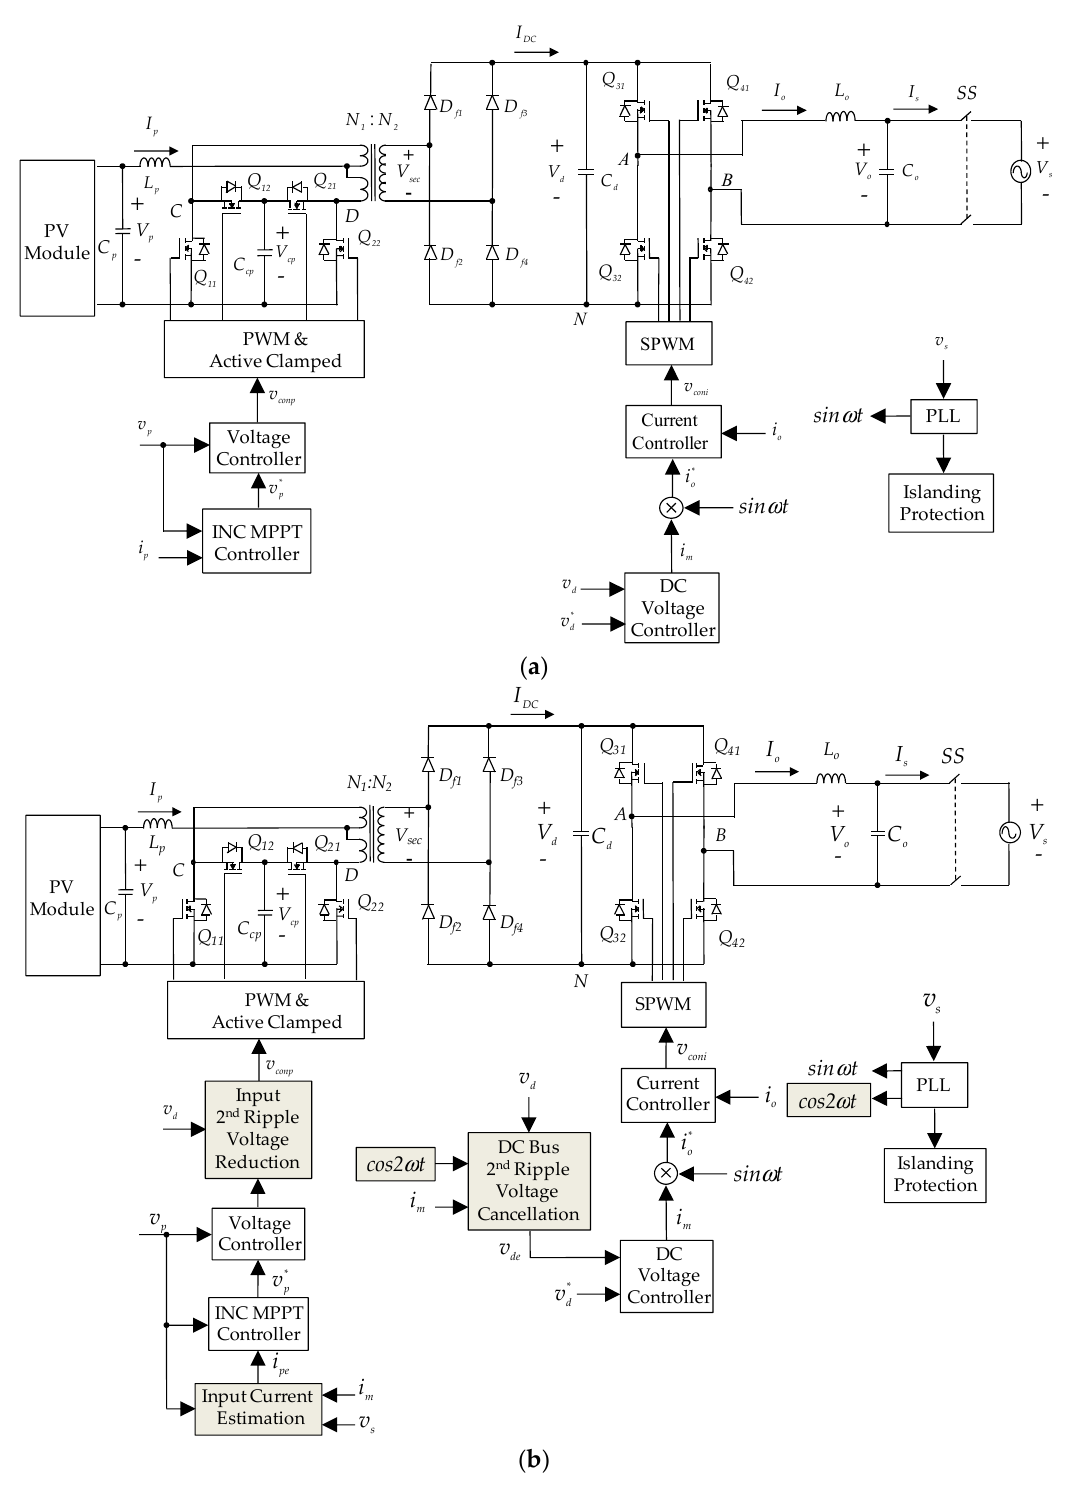
Figure 1. Two-stag e MI with current-fed push-pull converter cascaded with full bridge inverter: ( a ) Figure 1. Two-stage MI with current-fed push-pull converter cascaded with full bridge inverter: conventional; ( b ) propo sed. ( a ) conventional; ( b )